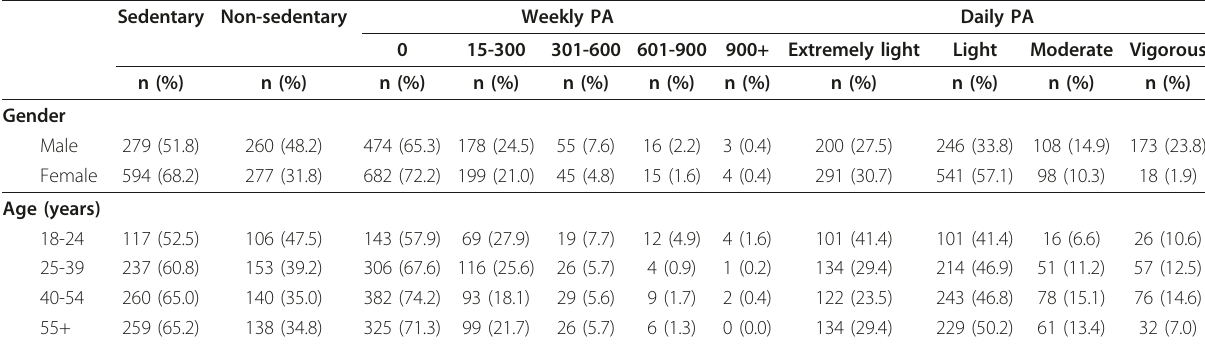
Table 2 Distribution of phenotypes according to gender and age groups in the study population Sedentary Non-sedentary Weekly PA